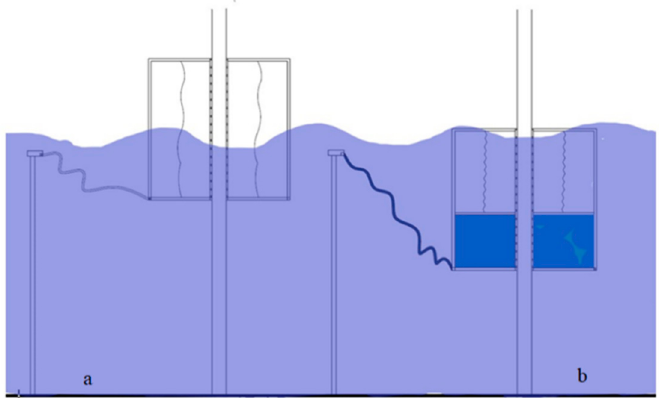
Figure 2. Stages of operation of the self-adjustable WEC.